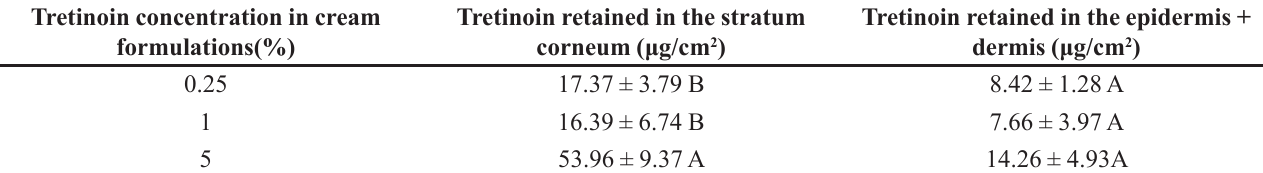
Tretinoin concentration in